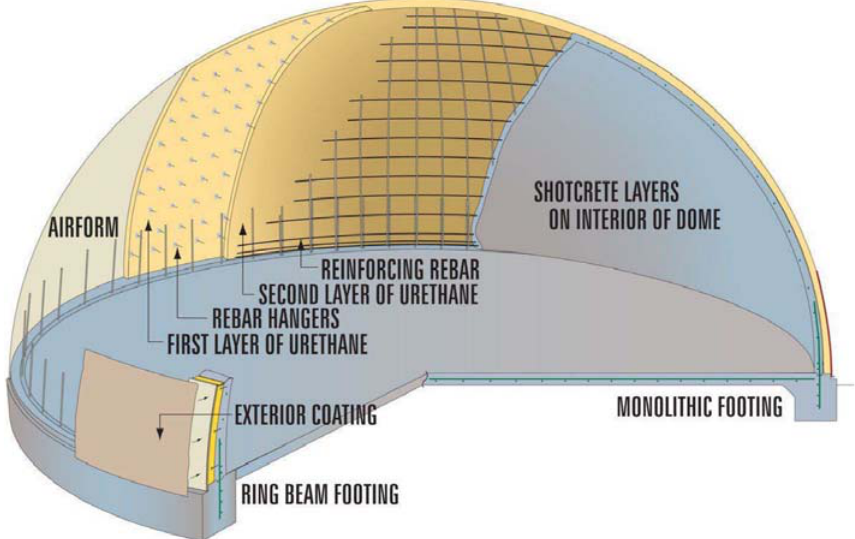
Figure 16: Schematic drawing of the construction method used by Monolithic © Monolithic